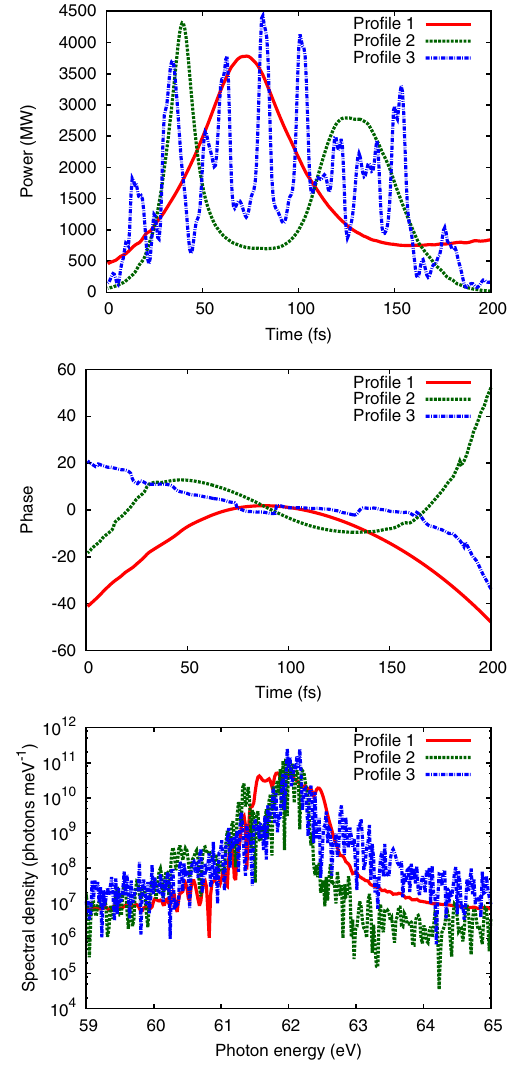
FIG. 5. Radiation characteristics at 20 nm after a single HGHG stage, showing power (top), phase (middle), and spectrum (bottom). The phases are shown as continuous functions.